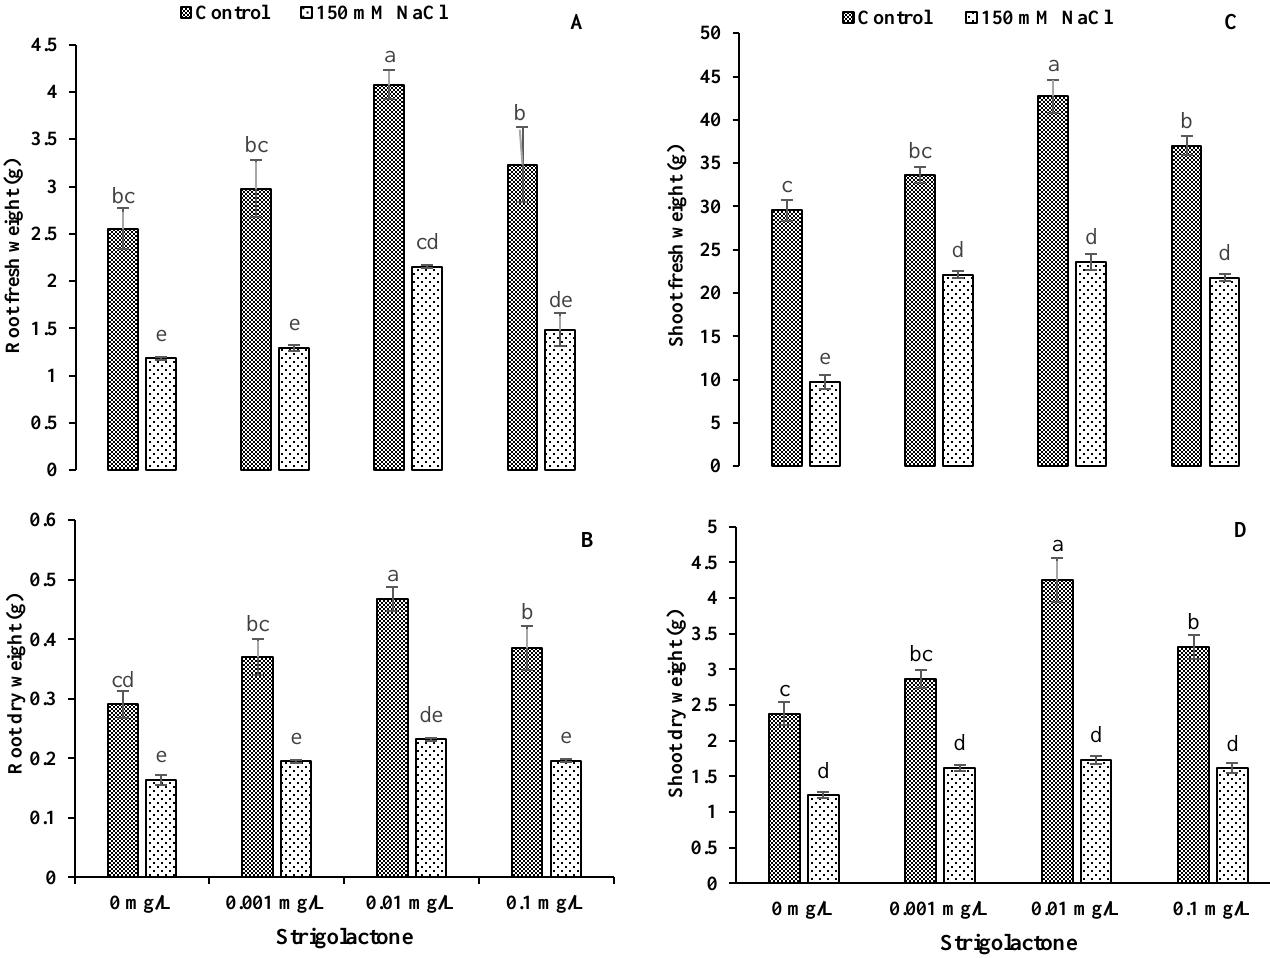
Figure 7. Impact of GR24 on root fresh weight ( A ), root dry weight ( B ), shoot fresh weight ( C ) and shoot fresh weight ( D ) of ornamental sunflower under control and salt stress conditions. Each vertical bar shows the mean of three replicates. Different letters indicate significant differences among treatments at p ≤ 0.01 according to least significant difference test.